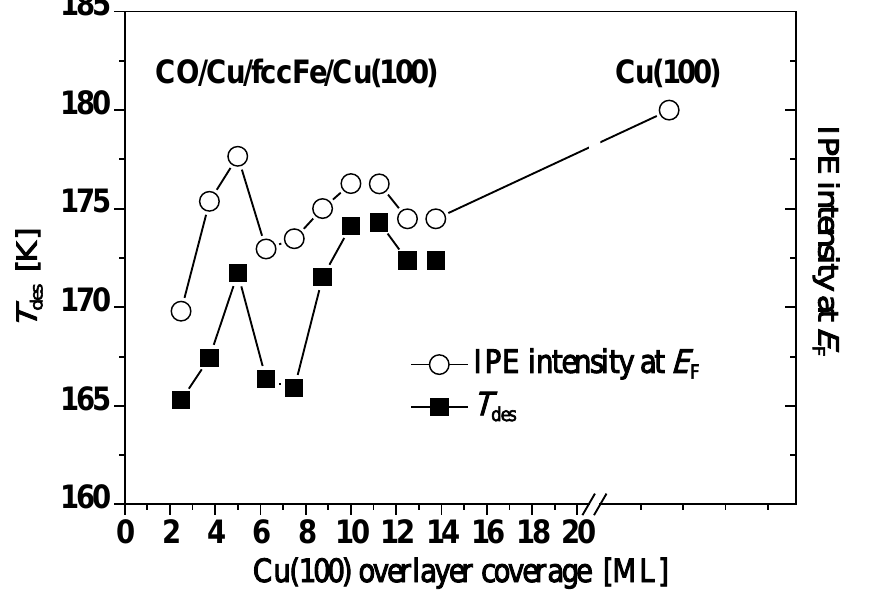
(open circles) and I ( E ) (closed squares) as a function of Cu Figure 10. Plot of T des F thickness. Adapted from [74] (Copyright American Physical Society